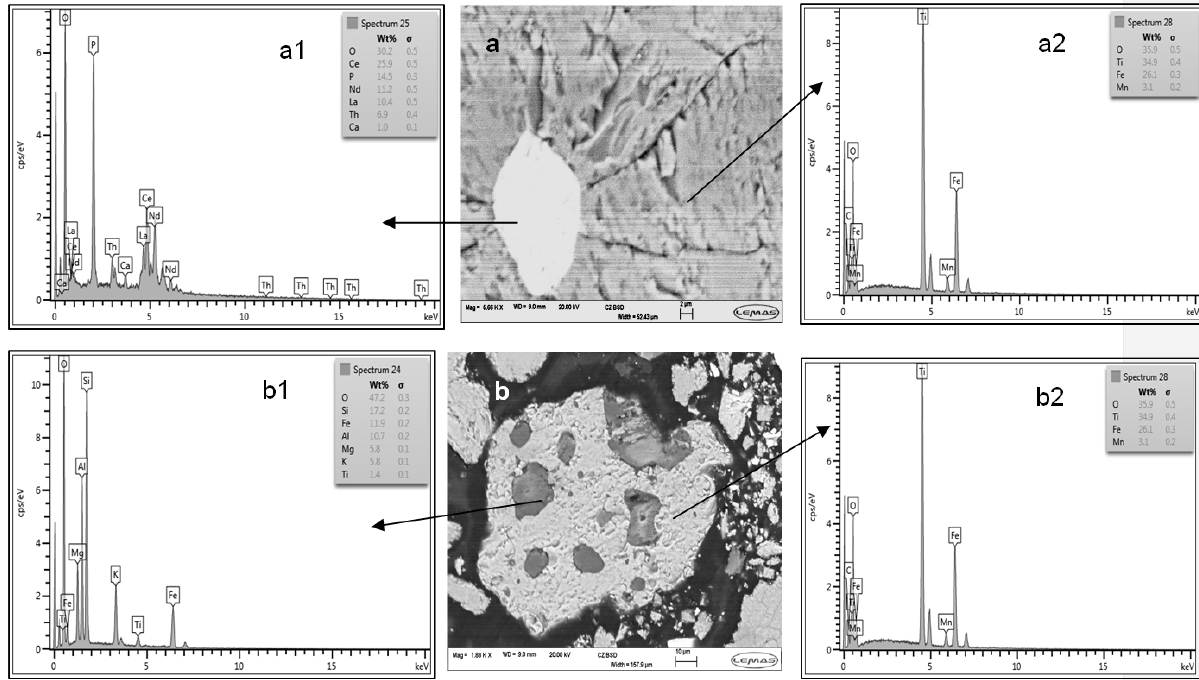
) inclusion. (a2) EDX of 4